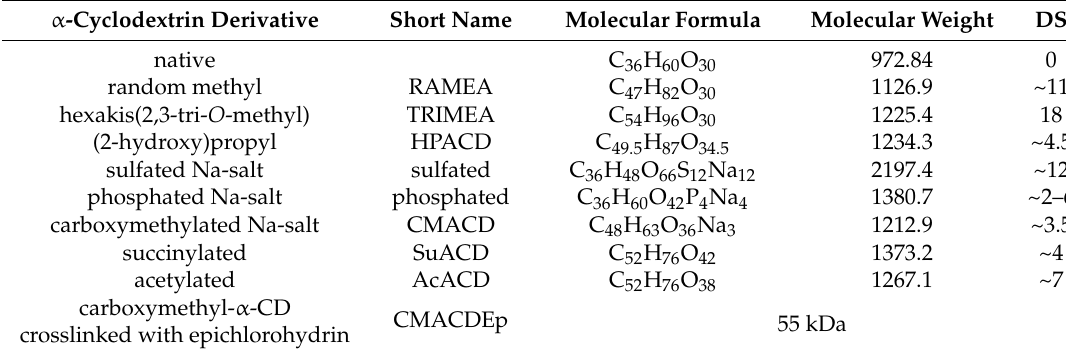
Table 2. Chemical description of used α -cyclodextrin derivatives (DS = substitution degree). α -Cyclodextrin